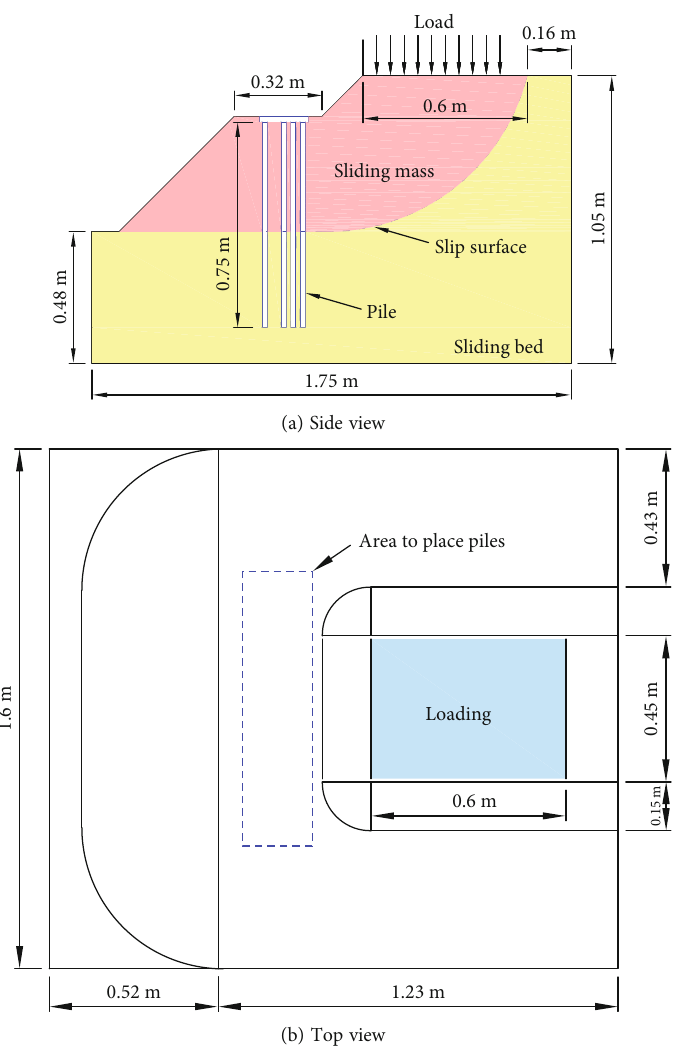
Figure 2: Test model of arch-chord-coupled antisliding